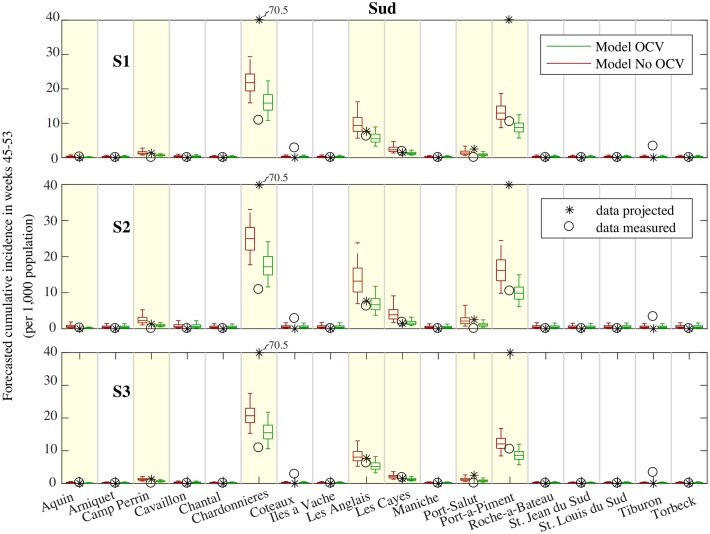
Forecasted incidence.Same as Fig 3 for the communes in Sud.